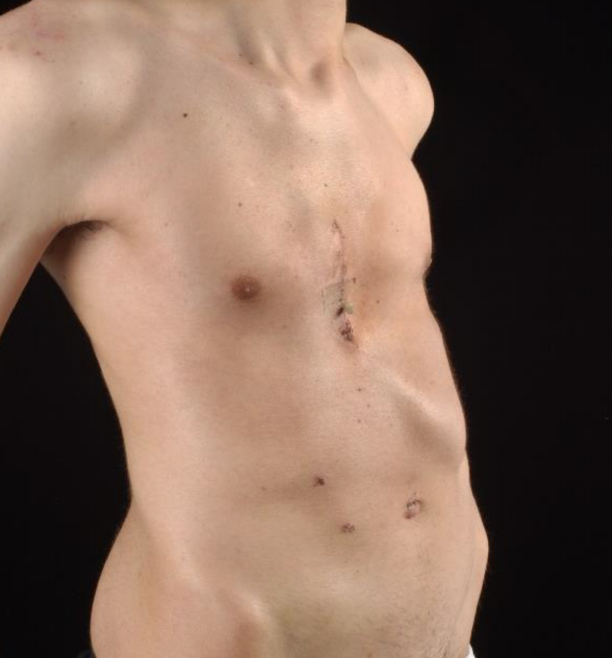
Figure 2. Same patient, clinical aspect after open pectus